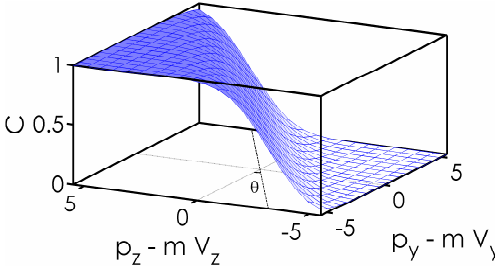
Fig. 2. The cutoff function in phase space is an important ingredient in tangential discontinuity models, as it ensures that a population is present on only one side of the TD interface. The plot illustrates the cutoff function for a transition length ‘ = 2 and an orientation of the cutoff line (where C = 1 / 2) given by θ = 30 ◦